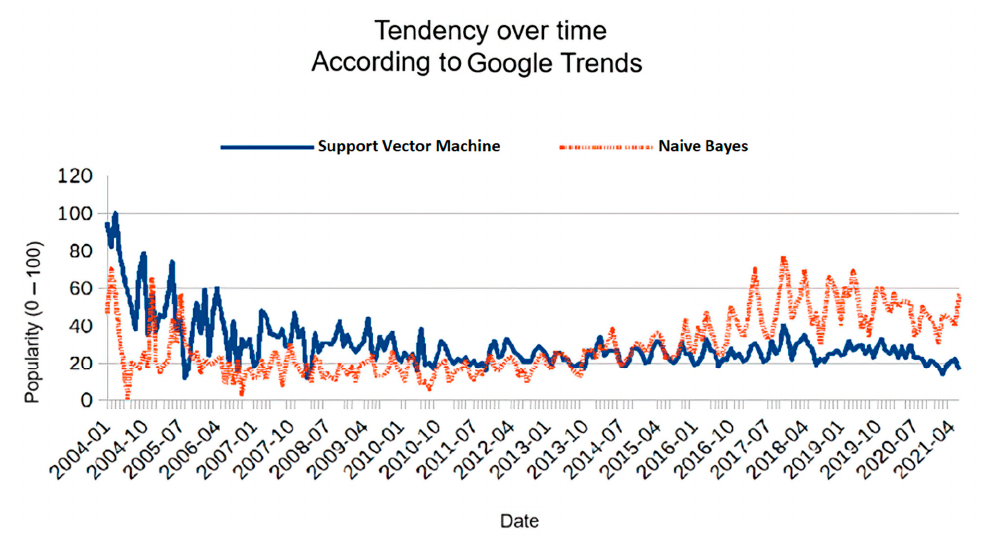
Figure 2. Global historic tendency of "Support Vector Machine" vs. "Naive Bayes”.